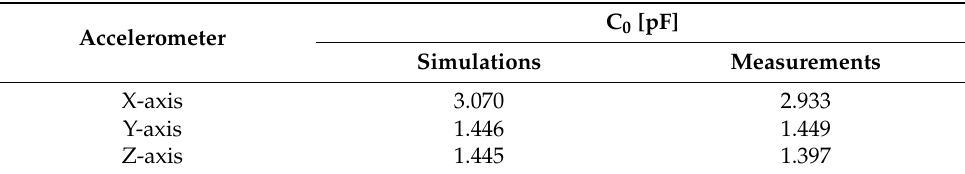
Table 2. Measurement and simulation results of the nominal capacitance of the X -, Y - and Z -axis accelerometer.